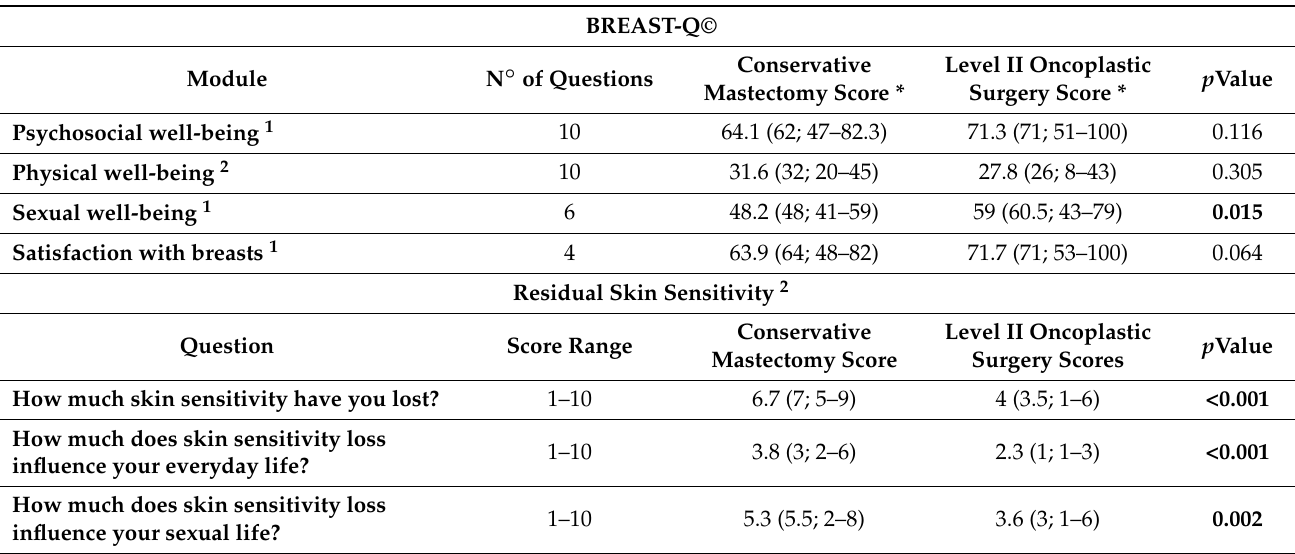
Table 5. Patient-reported outcomes (data obtained from the 124 patients who completed all Table 4. Surgical and Oncological Outcomes.